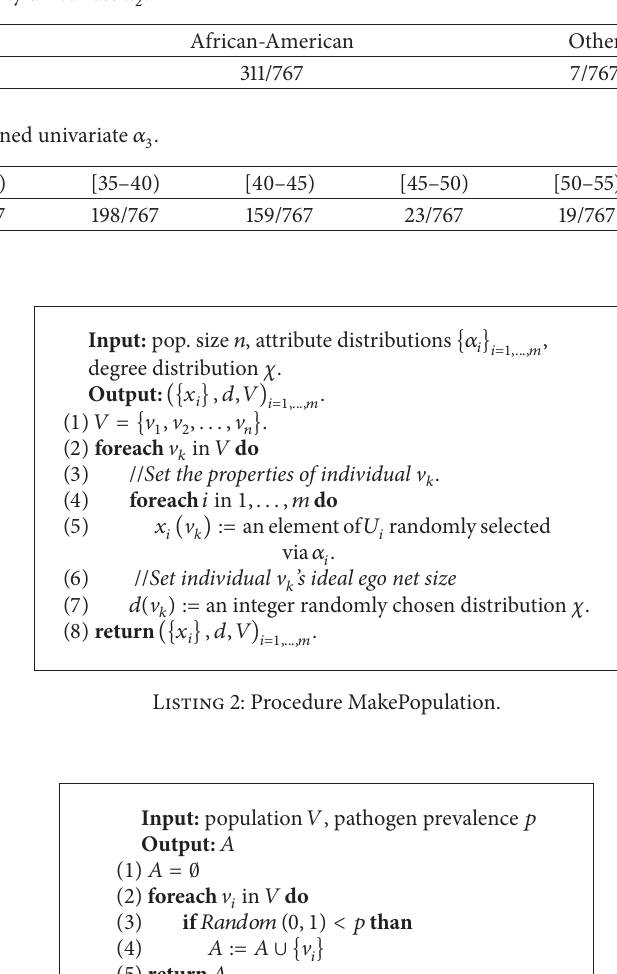
Table 3: Ethnicity univariate 𝛼 2 .